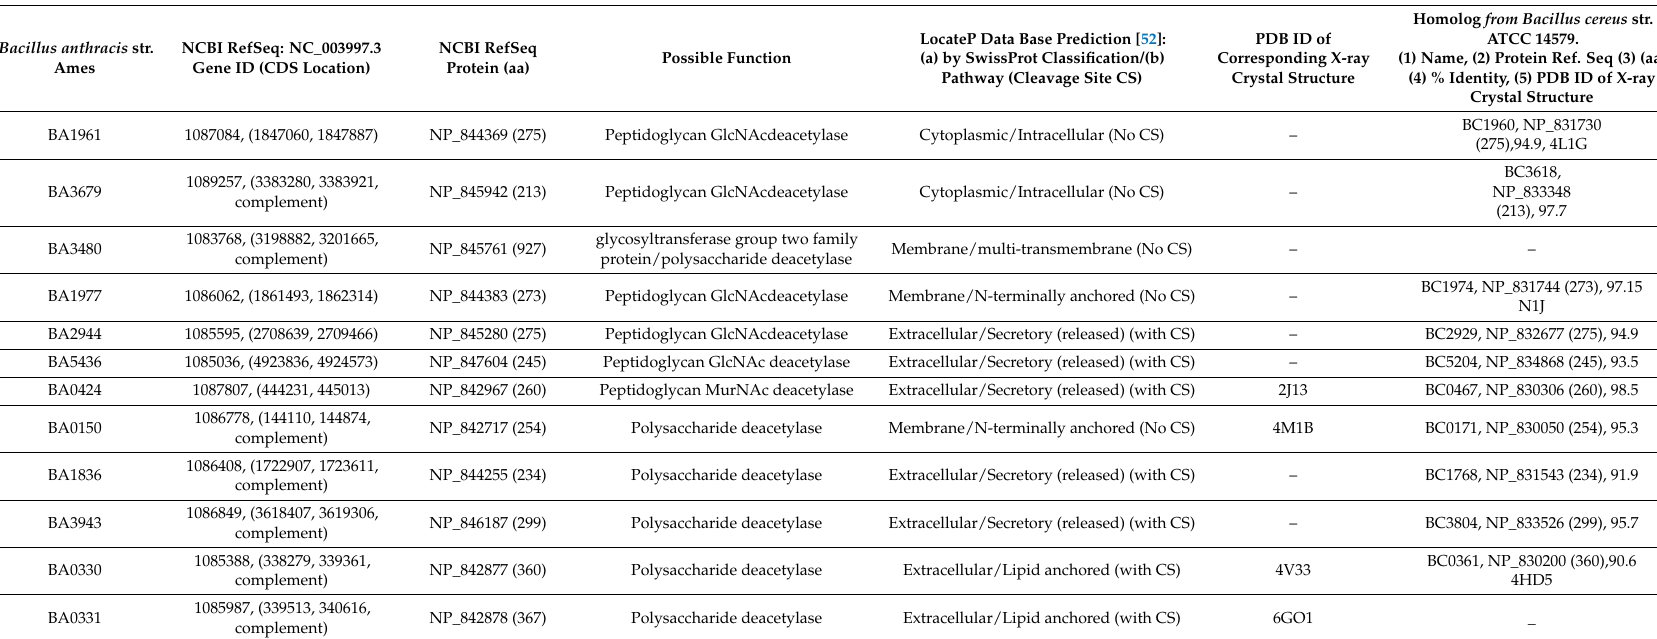
Table 1. PDAs of the Bacillus anthracis str. Ames studied as well as designation, accession numbers, putative function, the localization prediction [51,52], the protein data base (PDB) ID and their homolog from Bacillus cereus ATCC14579.